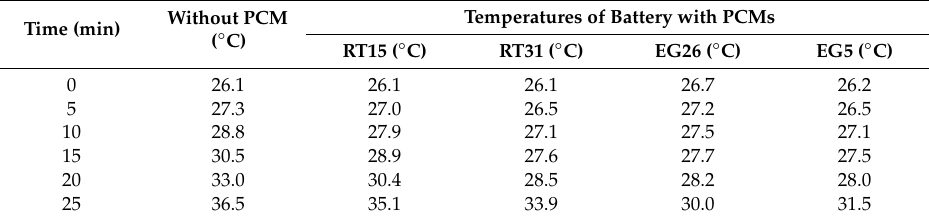
Table 6. Thermal performance of proposed model with load test